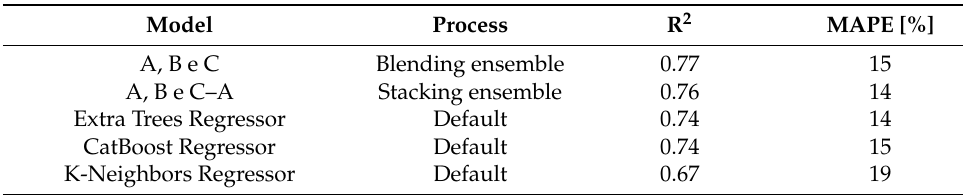
Table 9. Results obtained on the test dataset, by default, stacking ensemble learning and blending ensemble learning model.